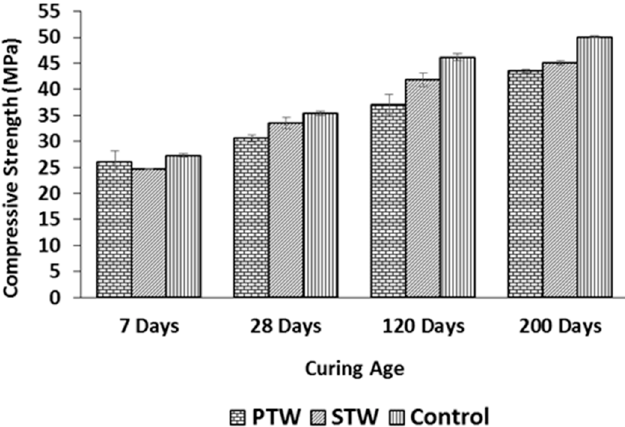
Figure 6. The compressive strength of lab scale concrete utilizing PTW, STW, and DW at curing age 7, 28, 120, and 200 days.